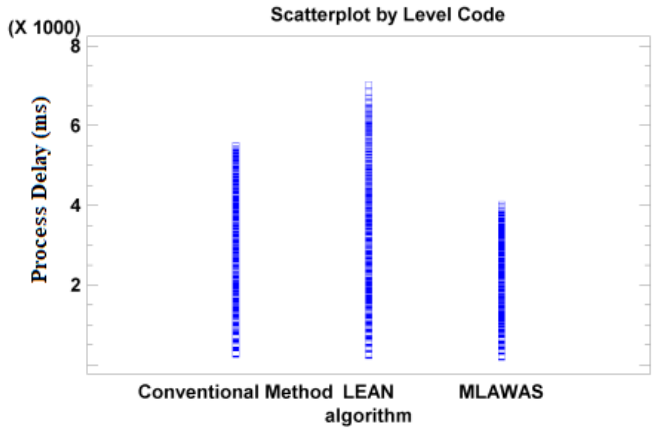
Figure 10. VM Migration